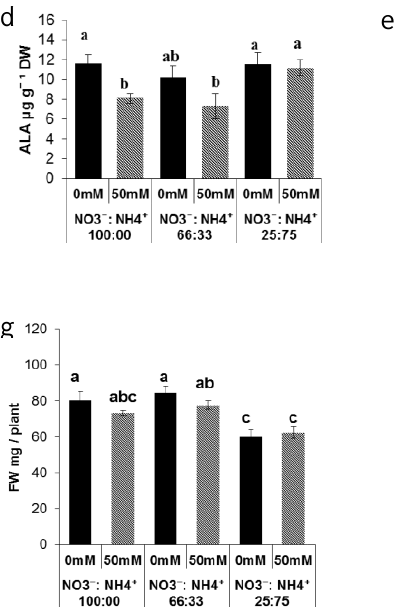
Figure 1. Effect of the nitrate to ammonium ratio (100:00, 66:33, 25:75) and salinity (0, 50 mM) on the leaf quality and biomass accumulation of P. oleracea leaves ecotypes ET (A) and RN (B). The values are means ± SE ( n = 6). Bars with different letters are significantly different between treatments, P ≤ 0.05, as determined by Tukey–Kramer HSD.